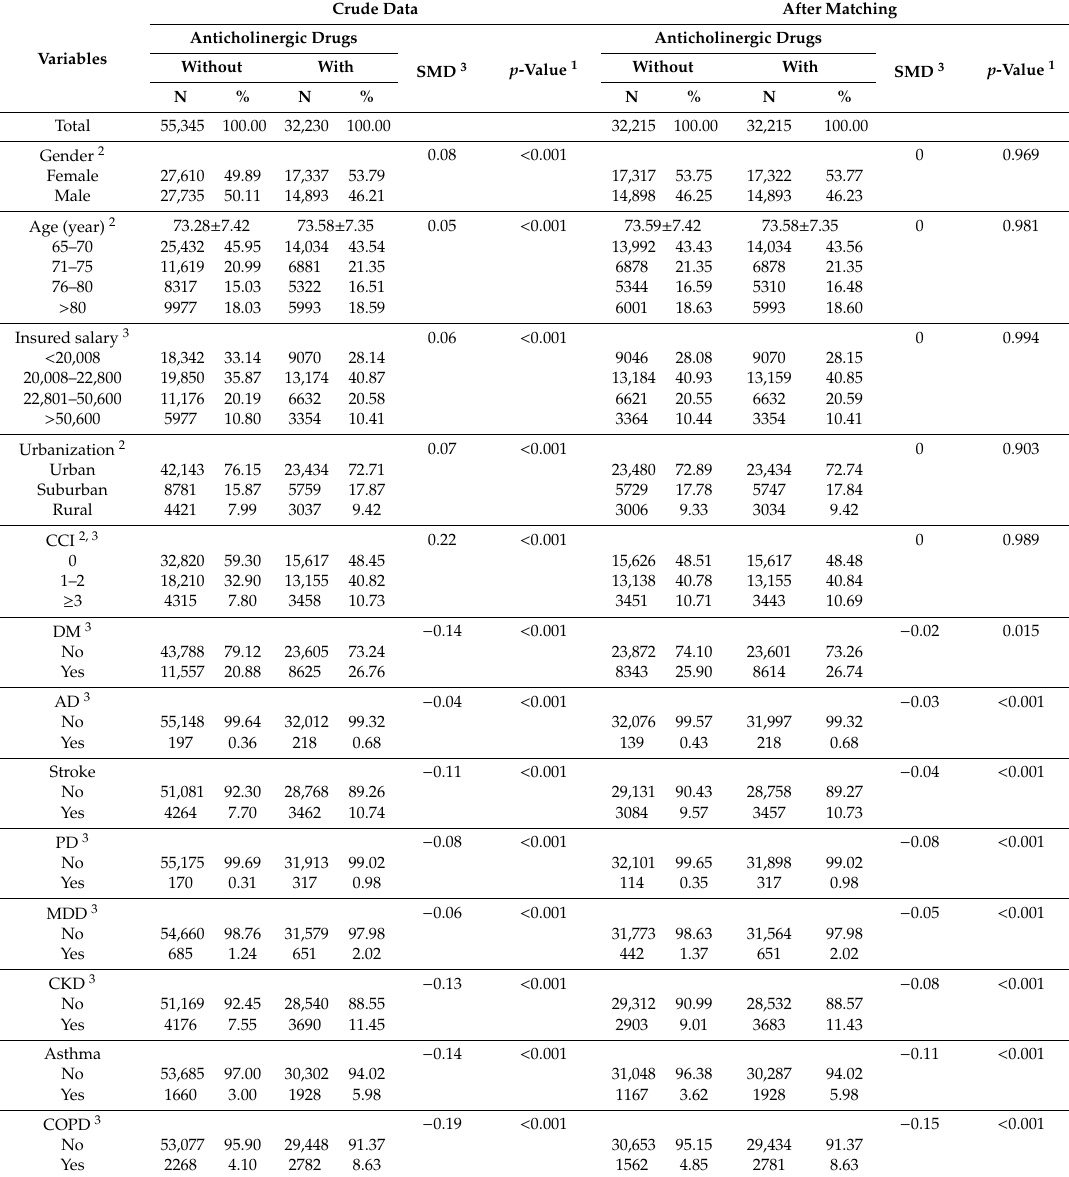
Table 2. The baseline characteristics distribution of study subjects after